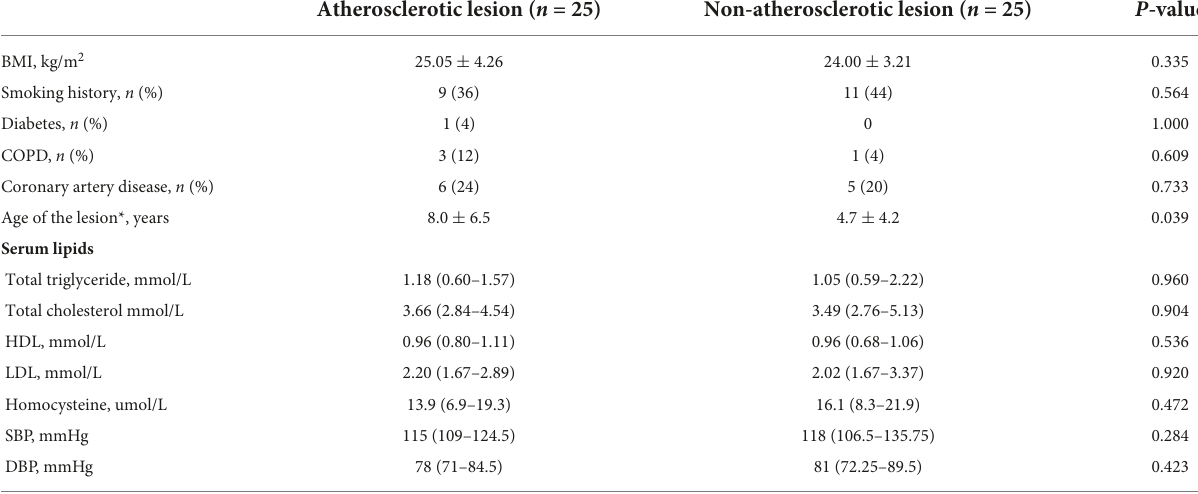
TABLE 2 Risk factors of atherosclerosis in CTEPH with and without atherosclerotic lesion. Atherosclerotic lesion ( n = 25) Non-atherosclerotic lesion ( n = 25)